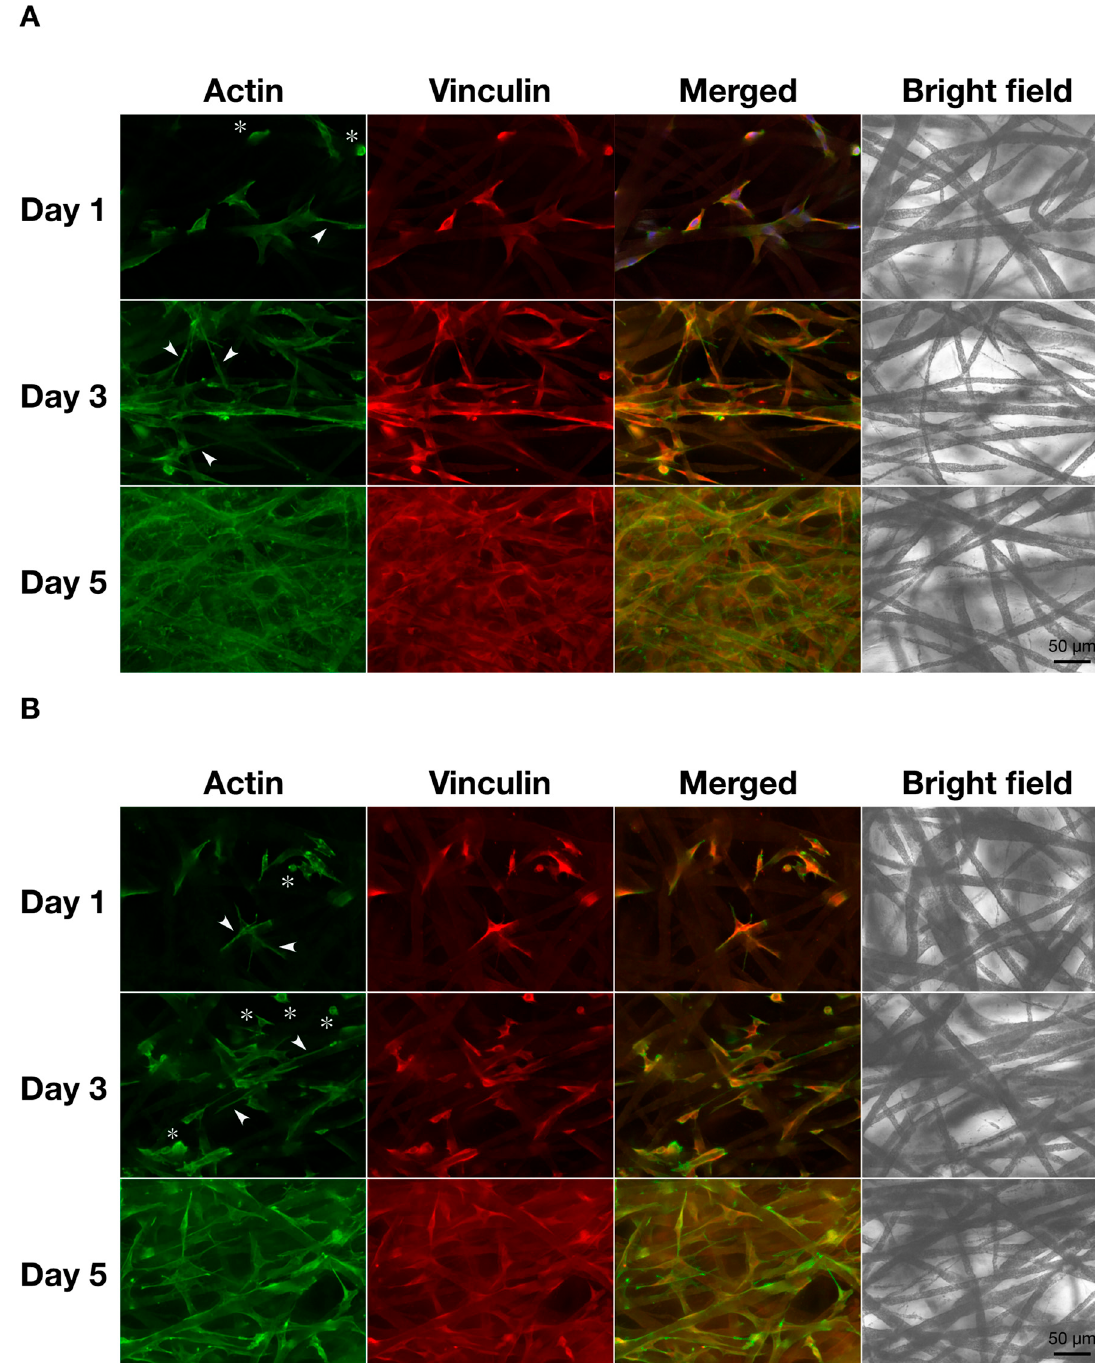
Figure 3. Morphological observation of ( A ) monoculture and ( B ) co-culture cells by immunofluorescence microscopy. Cells were seeded at 5.0 × 10 4 cells cm –3 on a microfiber mesh scaffold placed in each well of a 24-well plate and cultured for 1, 3, and 5 days. At the culture time, the cells were fixed and stained with Alexa Flour ® 488-labeled phalloidin for actin (green) and anti-vinculin for vinculin (red). They were viewed through a fluorescence phase-contract microscope at 20× magnifications (scale bars: 50 μ m). Arrowheads show the spindle-shaped cells and asterisks indicate shrinkage-rounded cells.